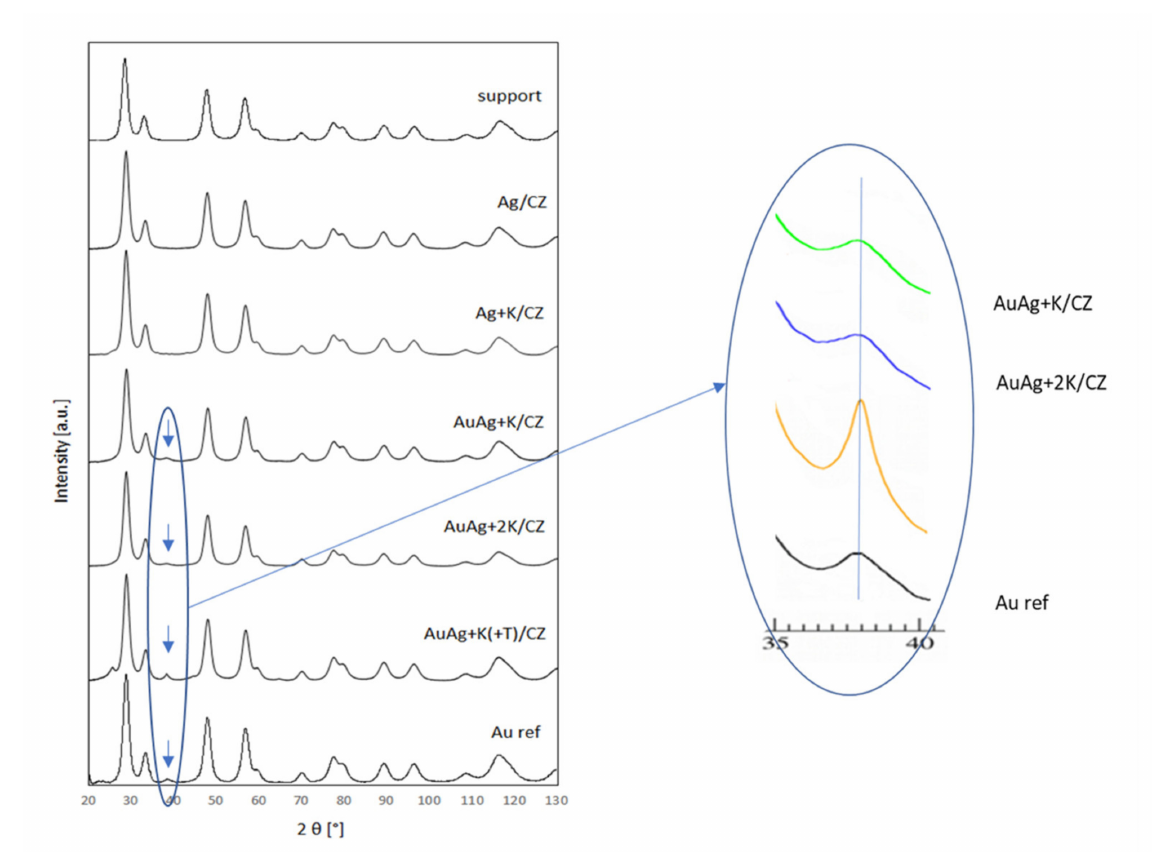
Figure 2. XRD results: diffraction patterns of the